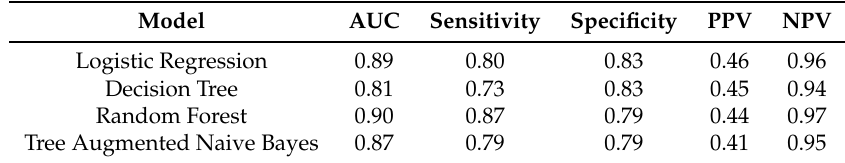
Table 4. Performance of the supervised models on the training set. PPV: Positive Predictive Value. NPV: Negative Predictive Value.